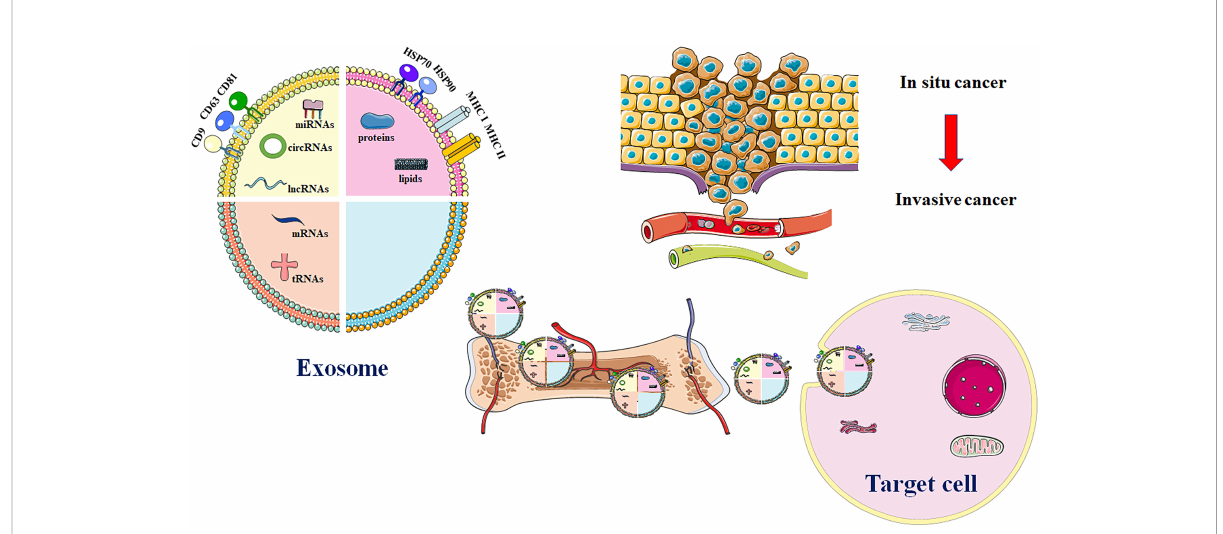
FIGURE 1 Major exosome release process in OS. EVs are comprised of various proteins and nucleic acids. These evolutionarily conserved proteins that can be used as biomarkers, like HSP70, CD9, CD63, and CD81. Additionally, exosomal cargos are also involved in transport of multiple biomolecules such as DNA or RNA. EVs that carry genetic materials are utilized in development of treatment for OS through enhancing drug resistance, immune evasion, migration, invasion, and angiogenesis. Source cell-derived exosomal cargos are also carried into recipient cells via blood circulation. Highly invasive OS cells enhance cell migration and invasion through production of